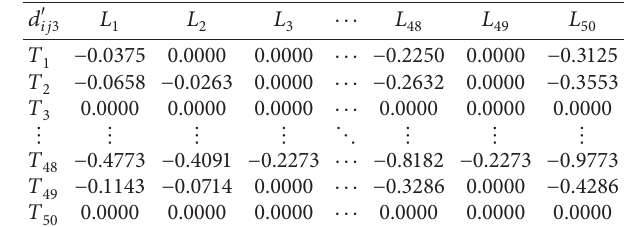
Table 21: Profit and loss matrix D housing rent.